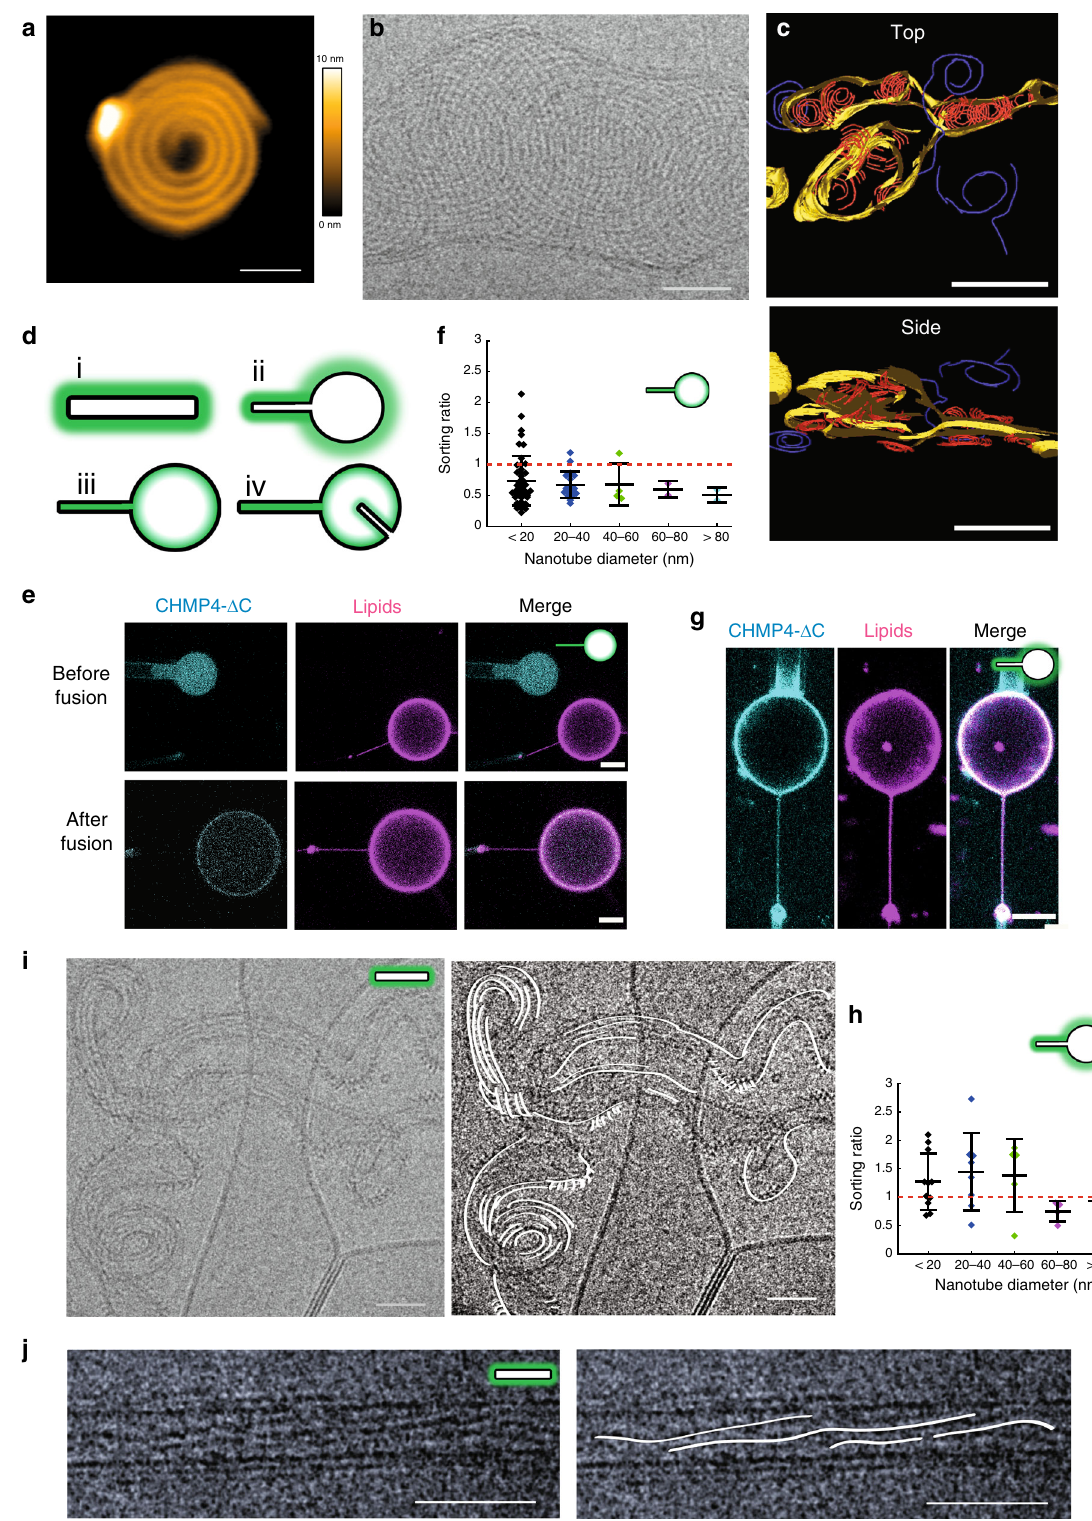
changing membrane tension with a micropipette aspirating the magenta membrane GUV. Using this setup, we observed that CHMP4B was neither enriched at the tube neck, nor in the tube. We calculated the sorting ratio, i.e. the protein enrichment in the tube as compared to the GUV, based on fl uorescence 47 ( N = 64 in total for 17 nanotubes). This ratio is larger than 1 for proteins enriched and lower than 1 for proteins depleted from membrane